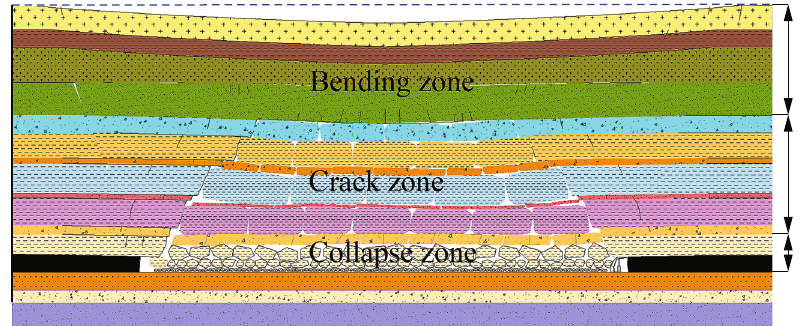
Figure 7: Schematic diagram of subsidence